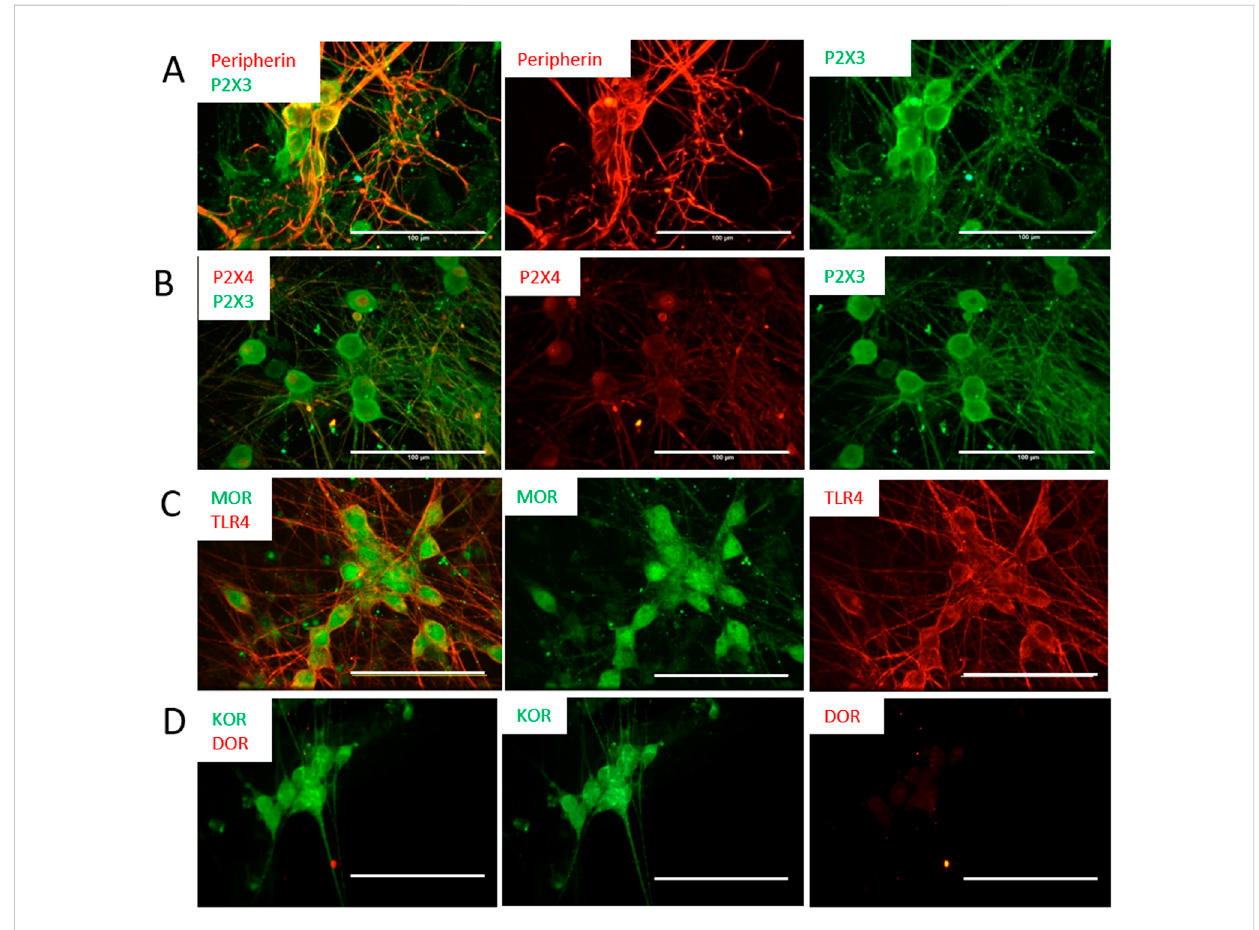
FIGURE 3 Expression of ATP and opioid receptors by the nociceptors was characterized by immunocytochemistry at D21. The cells are positive for the P2X3 antibody (A) , but negative to the P2X4 antibody (B) , con fi rming their nociceptive identity. (C) The cells showed positive staining to the µ-opioid (MOR) and TLR4 receptors. (D) The cells indicated positive staining to KOR but were negative for DOR. Scale bar: 100 μ